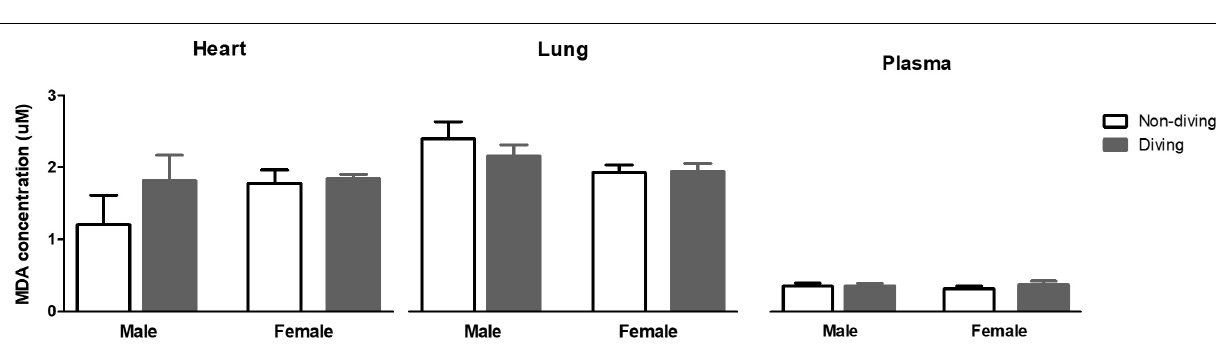
FIGURE 10 | Lipid peroxidation in blood plasma, lung and heart measured as malondialdehyde (MDA) concentration, and normalized to total protein content in ApoE KO rats; ANOVA and t